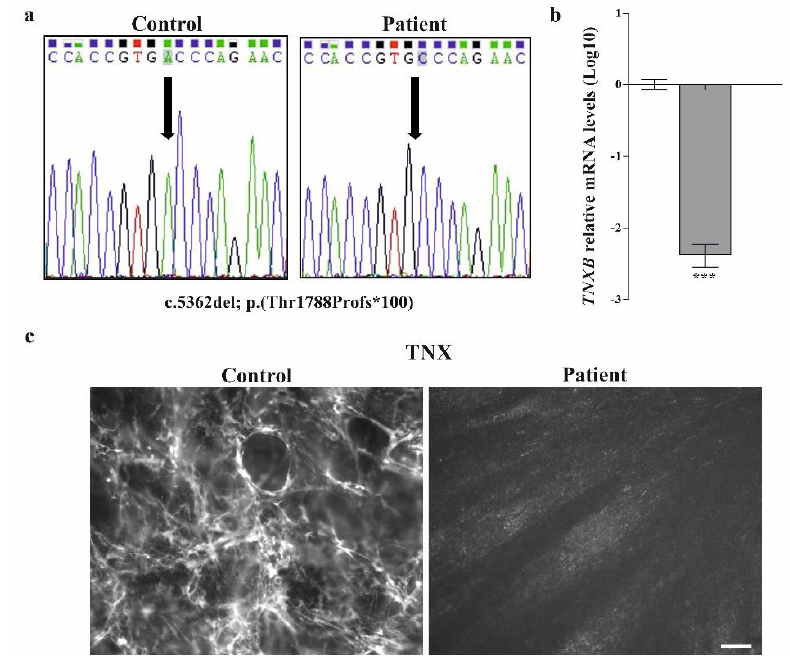
Figure 3. The TNXB c.5362del pathogenic variant causes nonsense-mediated mRNA decay and absence of the tenascin X protein in the ECM. ( a ) Sequence chromatograms showing the position of the novel c.5362del; p.(Thr1788Profs*100) variant (arrow) identified in homozygosity in exon 15 of the TNXB gene by Sanger sequencing; ( b ) qPCR analysis on cDNA obtained from patient’s dermal fibroblasts showed